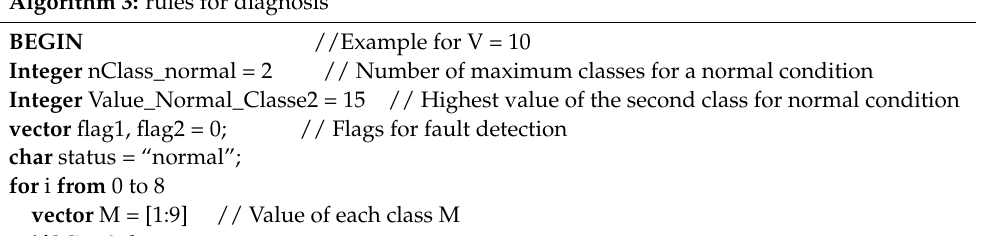
Algorithm 3: rules for